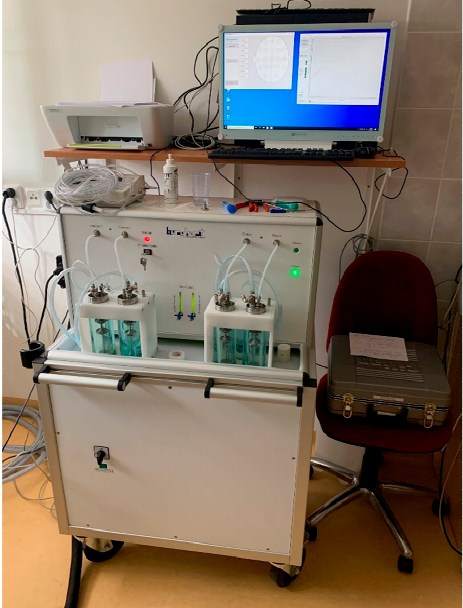
Figure 7. The olfactometer OL 024 Burghart (from author’s archive).